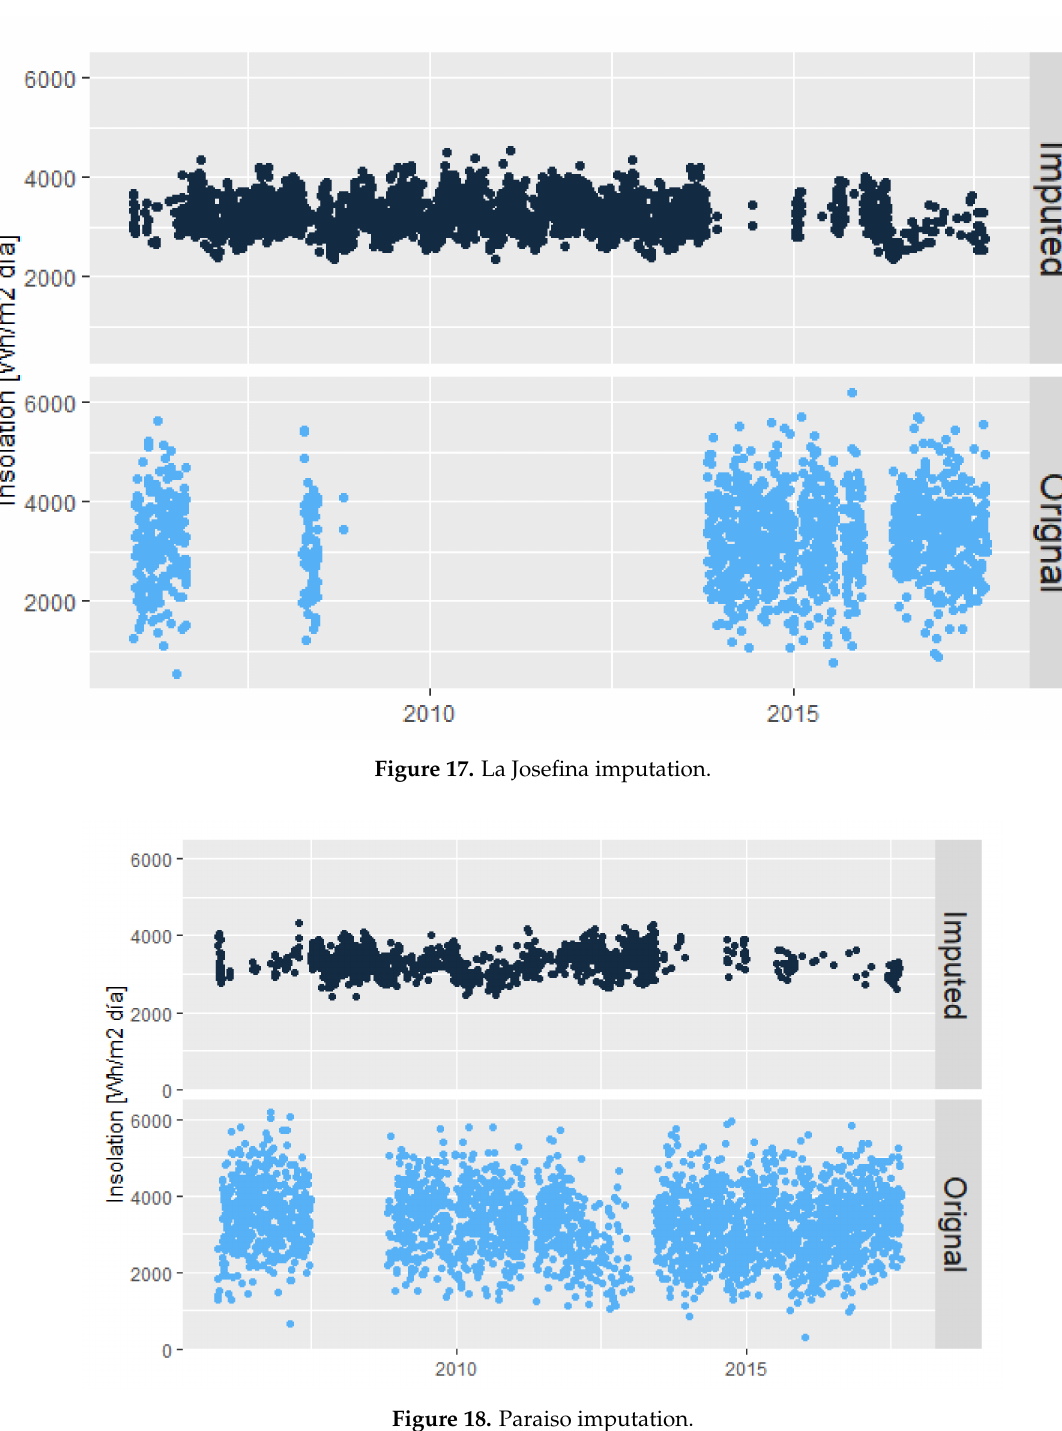
Figure 18. Paraiso